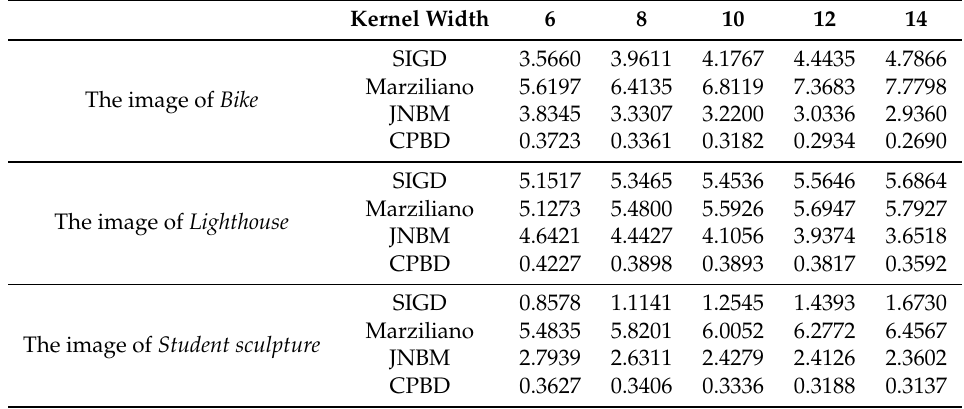
Figure 3. Three linear motion blurred images used in our experiments. Table 1. Estimated blurred degree on linear motion blurred